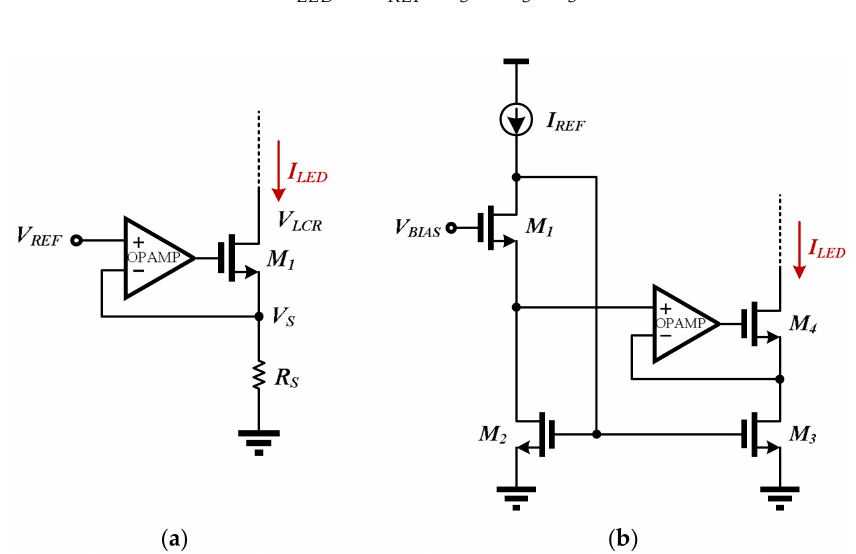
Figure 7. Constant current source with ( a ) a linear current regulator and ( b ) a current